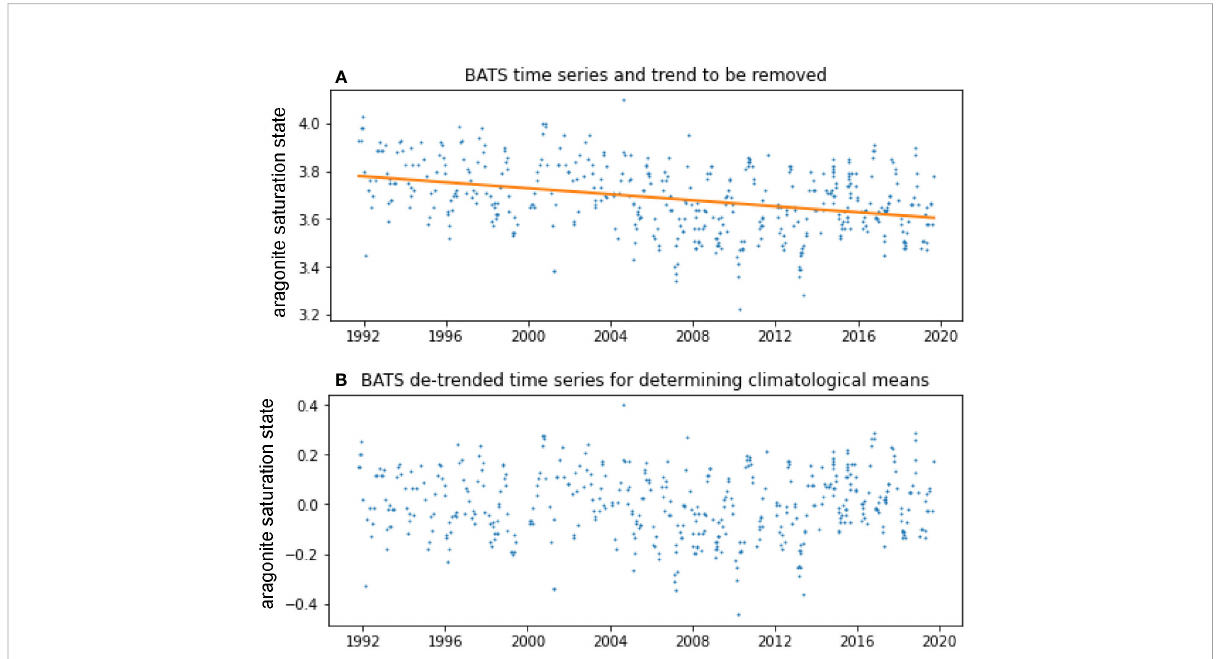
FIGURE 3 (A) Bermuda Atlantic Time-series Study (BATS) surface (< 10 m depth) aragonite saturation state (blue) calculated using measurements of temperature, salinity, inorganic nutrients, DIC, and TA in PyCO2SYS (Humphreys et al., 2022) with the constants recommended by Orr et al. (2018) and the associated linear trend (orange). (B) The same time series with the trend removed (shown as anomalies around zero), which is used for calculating monthly adjustments (Figure 4) that remove the seasonal cycle from the time series of monthly means.